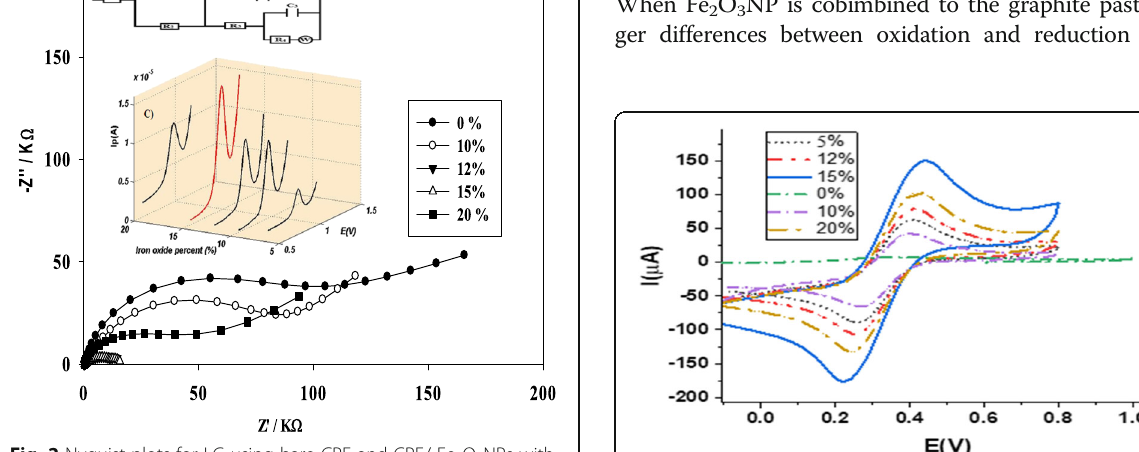
Fig. 2 Nyquist plots for LG using bare CPE and CPE/ Fe 2 O 3 NPs with different concentration of Fe 2 O 3 NPs. Inset 1: Equivalent circuit. Inset 2: Electrochemical oxidation responses of LG using different concentrations of Fe 2 O 3 NPs